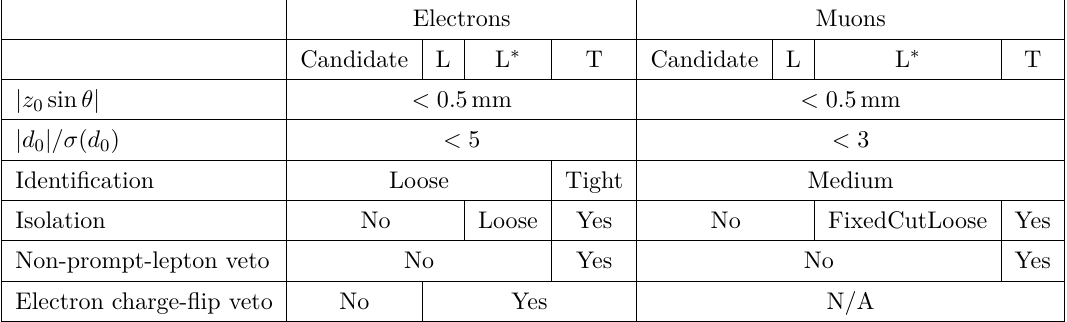
Table 3 . The requirements applied to define the categories of candidate leptons: loose (L), loose and minimally isolated (L ∗ ) and tight (T) leptons. The overlap removal procedure is not applied for the candidate leptons. In the 2 ‘ sc channel, the photon conversion veto is required in addition to the loose and tight